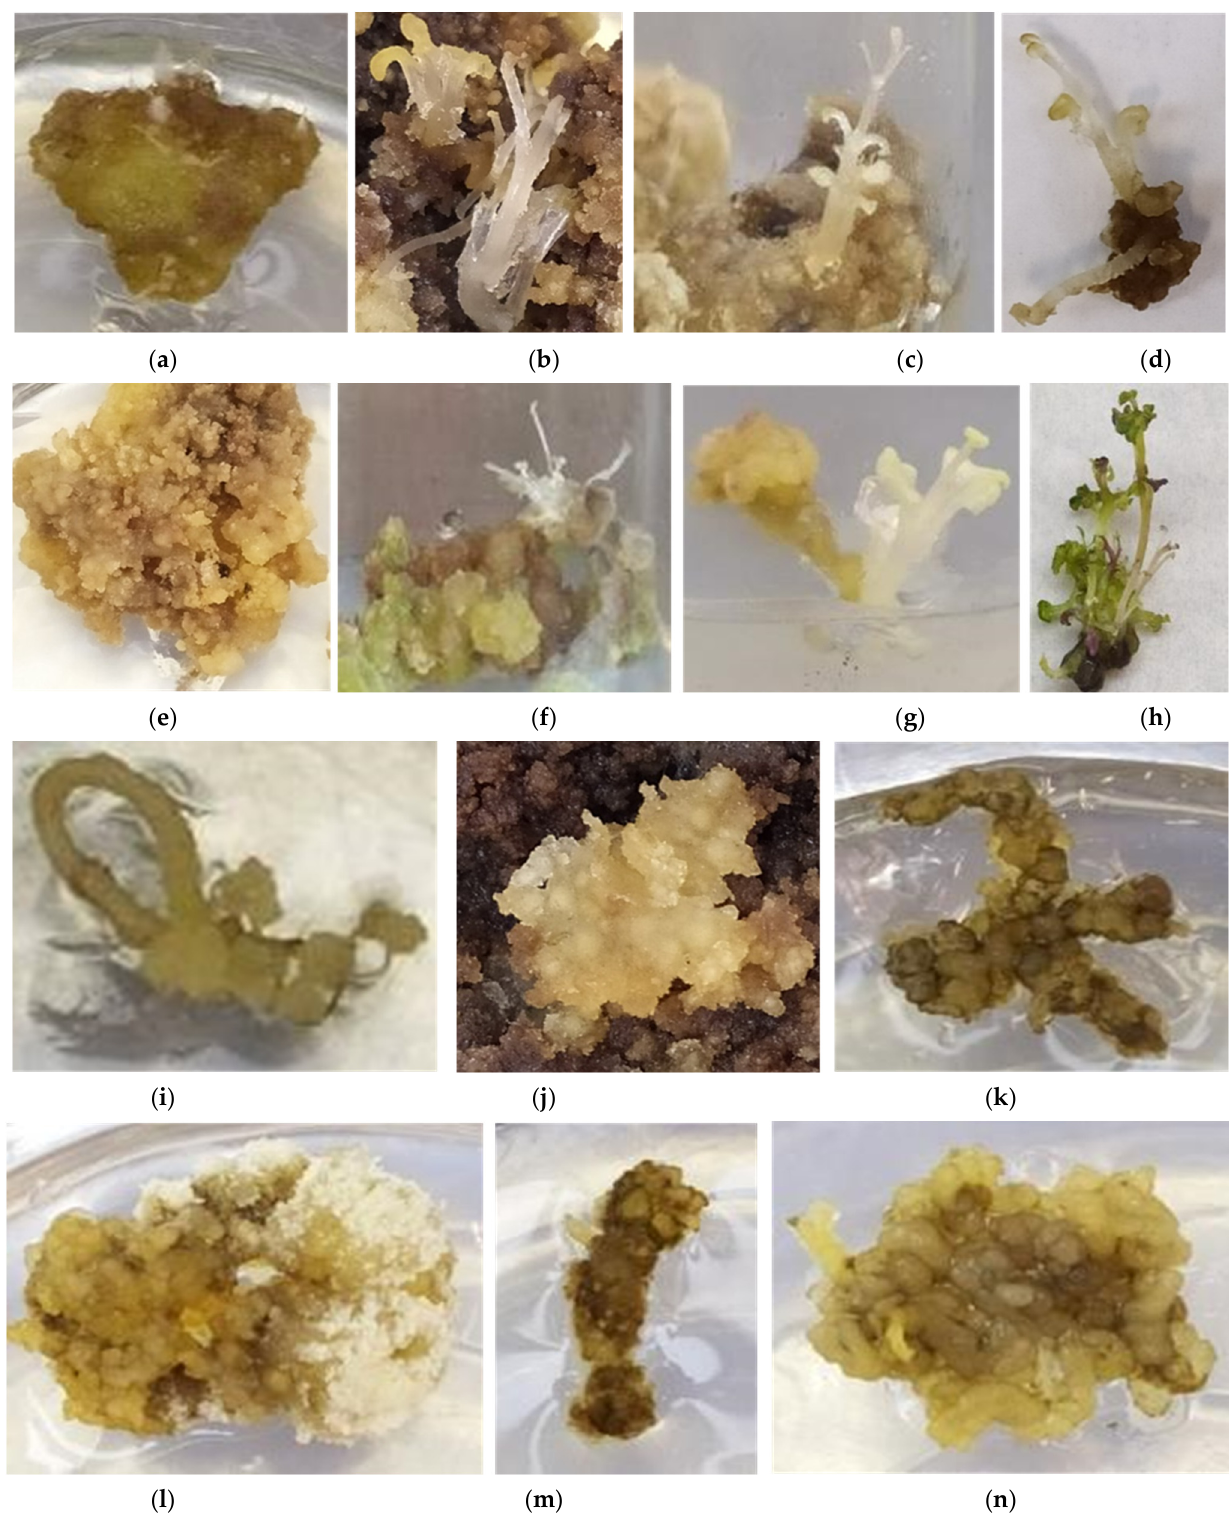
Figure 3. In vitro culture of three explant types (leaves, petioles, roots) of O. dictamnus L. in different media after two months: ( a – d ) Root, callus and shoot formation from leaf explants in ODK1; ( e – h ) Callus and shoot regeneration from petioles in ODK1; ( i , j ) Callus formation on root explants in ODK1; ( k ) Callus formation in root explants in ODK2; ( l – n ) Callus formation on leaf, petiole and root explants, respectively in ODK2. (Scale bar: 1